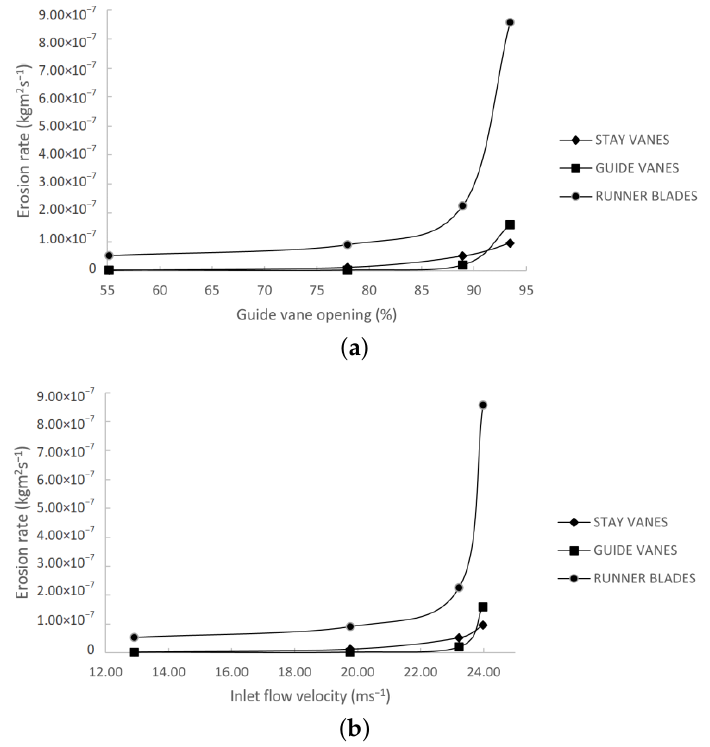
Figure 13. Erosion rate as a function of ( a ) guide vane opening and ( b ) inlet velocity.